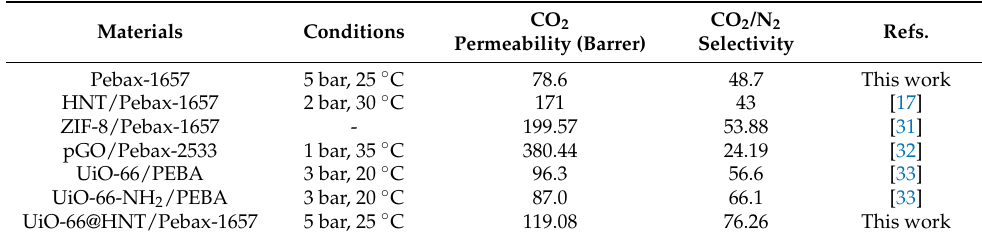
Table 3. Comparison of the separation performance of other MMMs based on Pebax substrates in the literature with our current work under dry